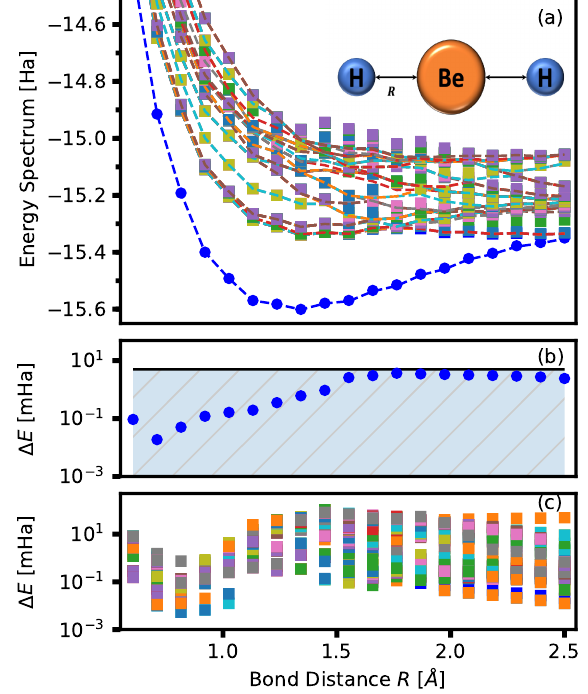
Figure 3. ( a ) The calculated binding curve of BeH 2 for the ground state and several excited states demonstrating the application of the method described in this work. ( b ) The difference between the ground state energies obtained from diagonalization of the exact and the effective Hamiltonian along with the chemical accuracy line, and ( c ) is energy difference for the obtained excited state spectra within the effective model and exact diagonalization.